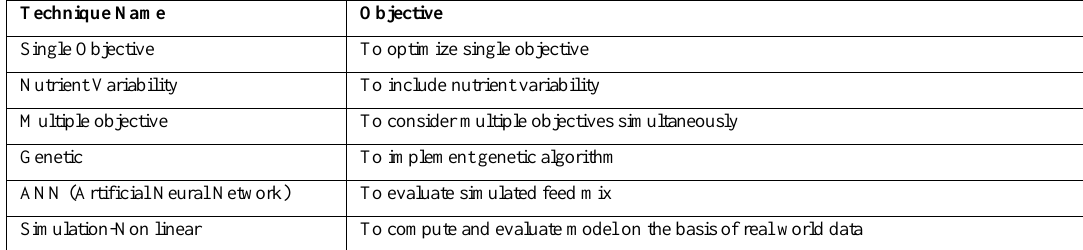
Table 1. Different techniques implemented in SIMFEED